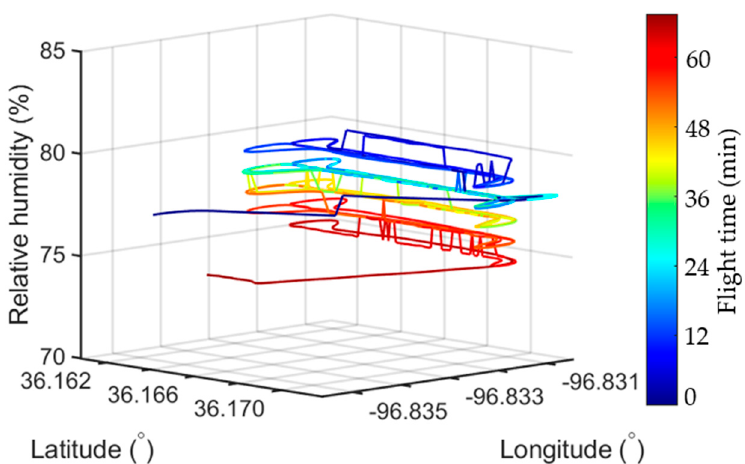
Figure 6 . GPS-resolved relative humidity measurements along the horizontal flight path during the morning of 28 June, 2017, from 7:06 to 7:57 am (UTC–5 h). The color bar represents the progression of flight time from blue in the beginning to red at the end of the flight.